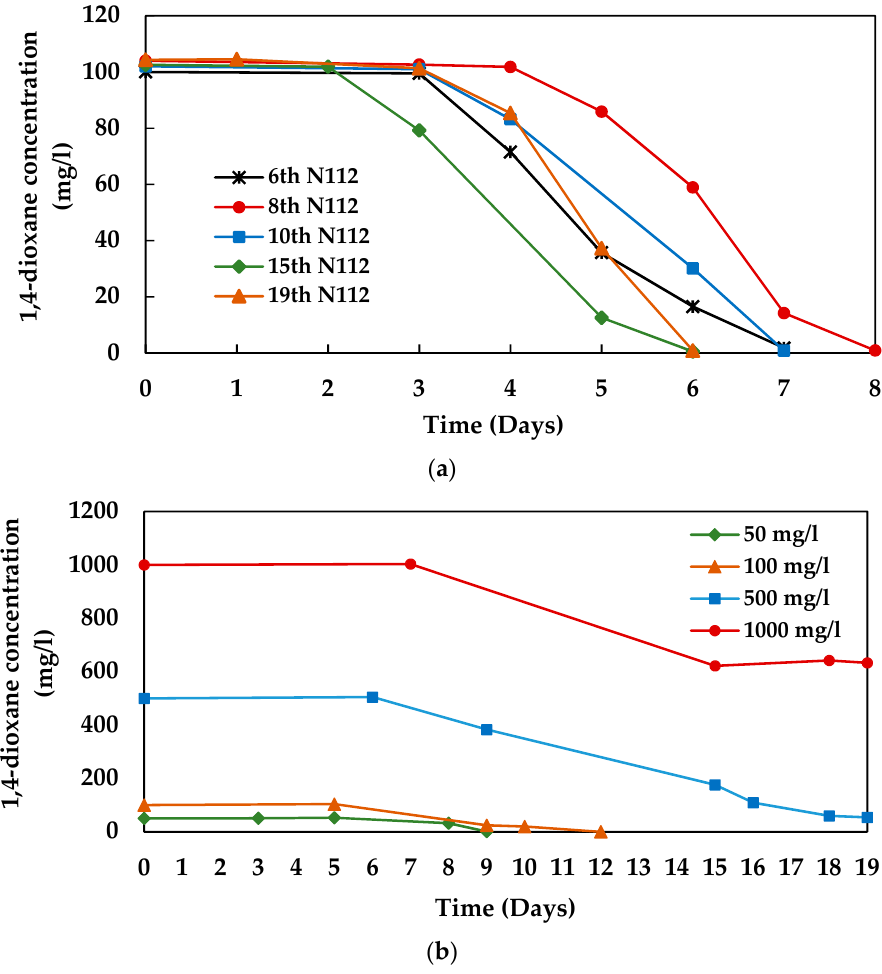
Figure 4. 1,4-dioxane degradation profile of the consortium N112, ( a ) by different generations and ( b ) at different initial 1,4-dioxane concentrations (by 2nd generation).